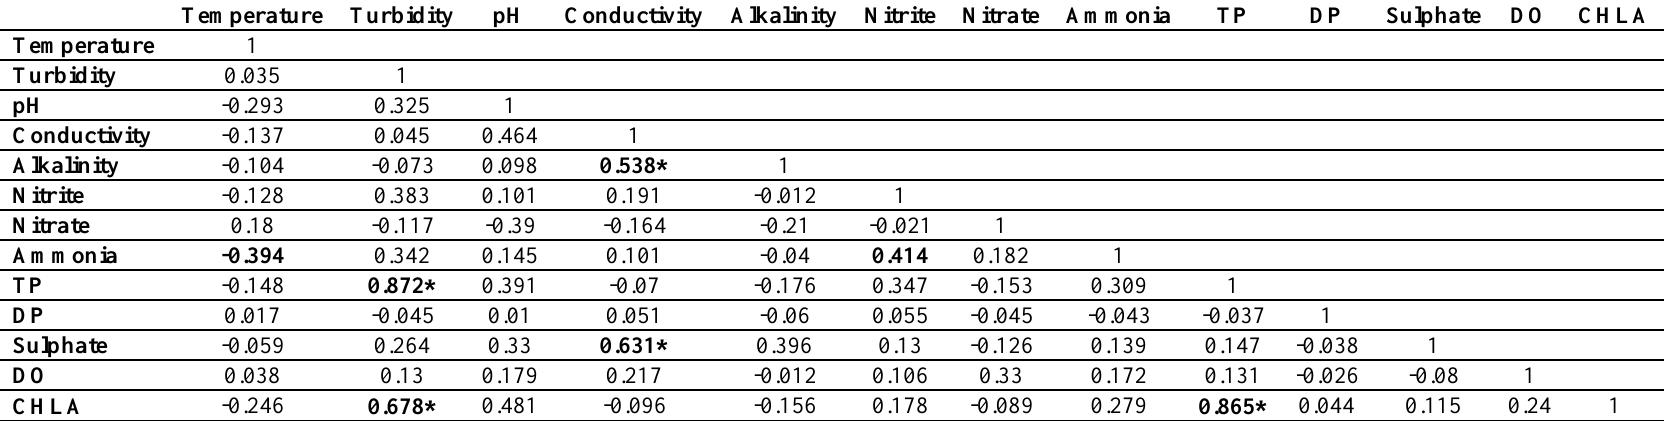
Table 2: Pearson correlation matrix on transformed environmental variables with Bonferroni adjusted probabilities for 13 measured environmental variables during the dry season in the 38 reservoirs. * Indicates significant correlation at p < 0.05.